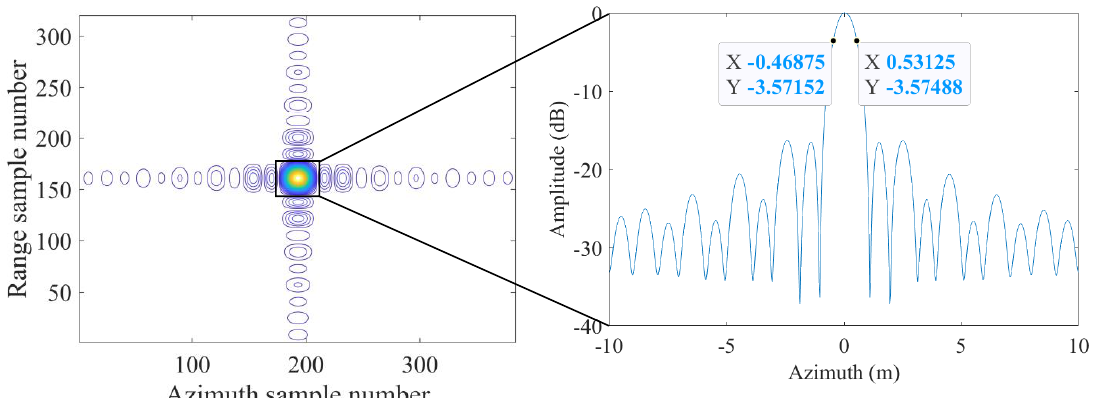
Figure 14. Interpolation refinement result of the proposed Topo-BPA.